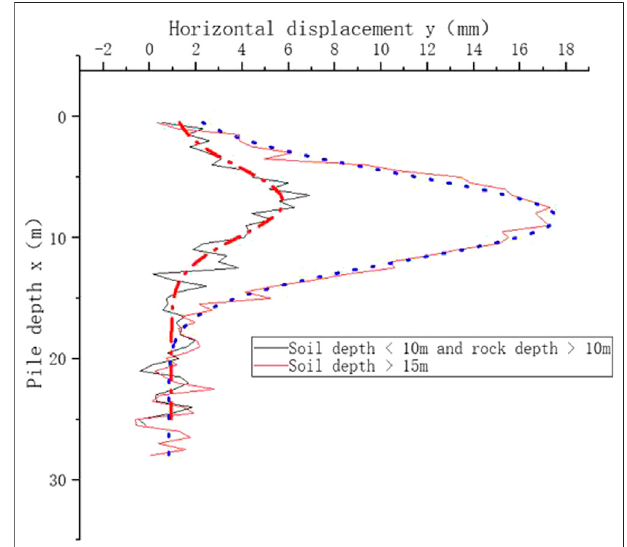
FIGURE5| Deephorizontaldisplacementcurveofpileundertwotypical strata.